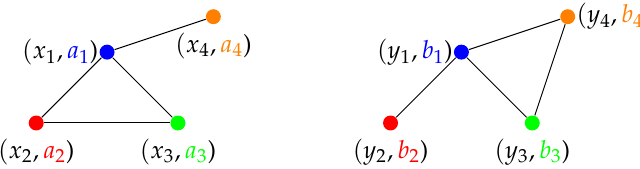
Figure 4. Two structured objects with isometric structures and identical features that are not strongly isomorphic. The color of the nodes represent the node feature and each edge represents a distance of 1 between the connected